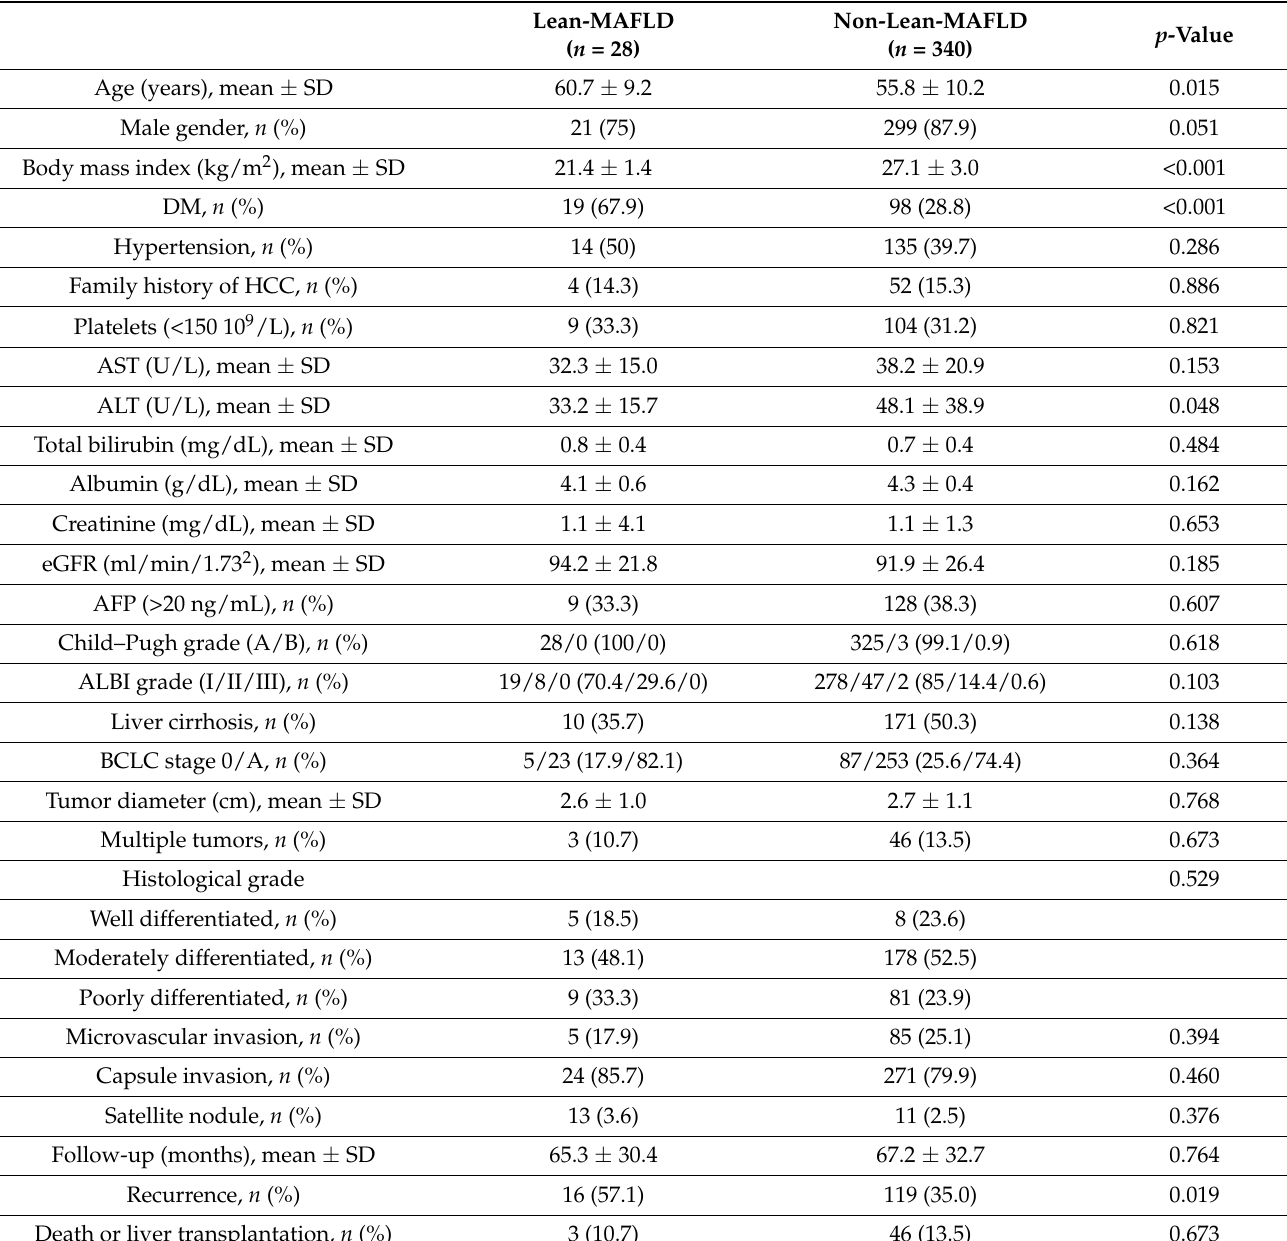
Table 5. Comparison of characteristics among patients with MAFLD-HCC stratified by lean (BMI < 23 kg/m 2 ) and non-lean (BMI ≥ 23 kg/m 2